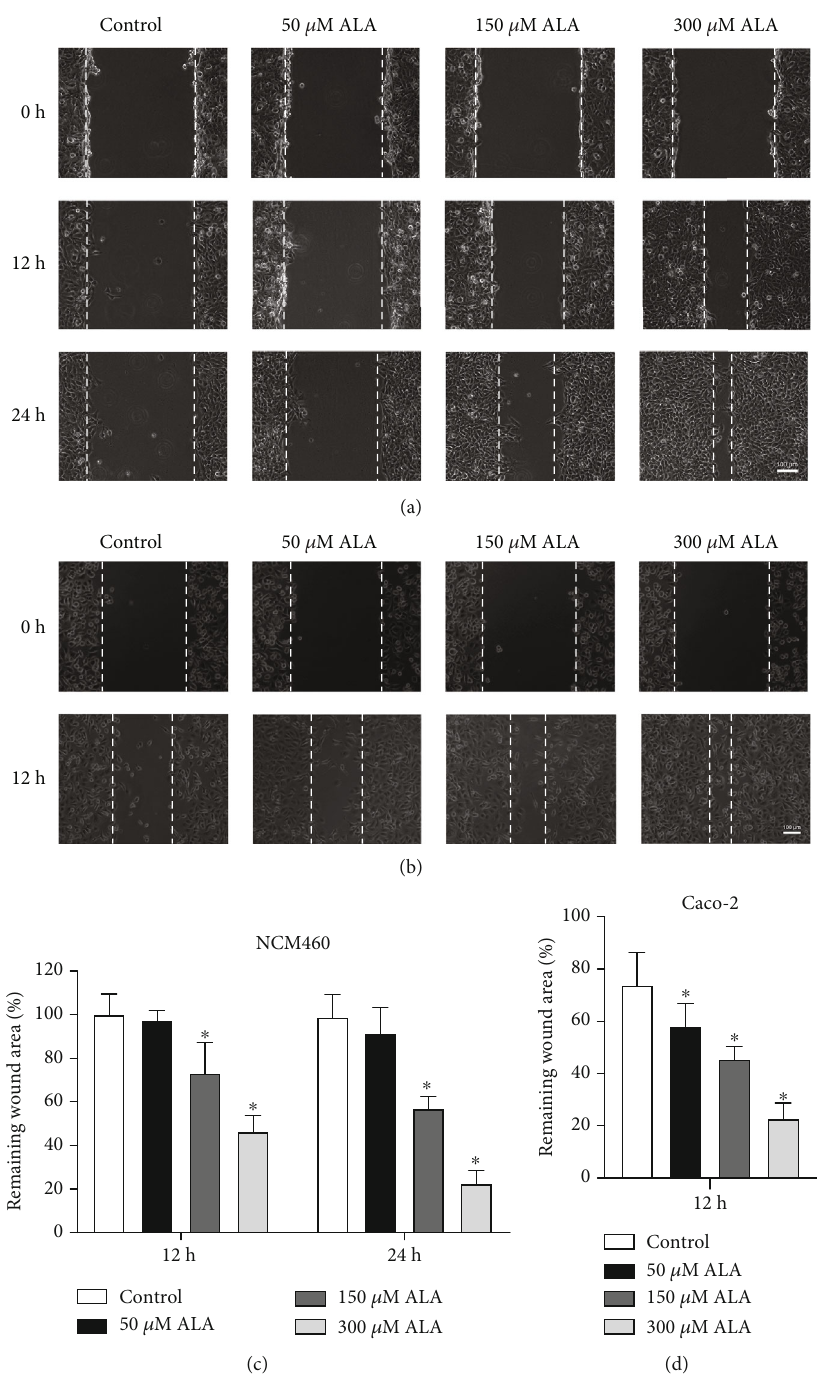
Figure 1: Restoration of epithelial cells treated with α -lipoic acid (ALA). (a) Representative images of cell wounds in wound healing assay of ALA (0 – 300 μ M) treated NCM460 cells. Wounds were created on the cell surface with the pipette tips, and then NCM460 cells were treated with ALA (0 – 300 μ M). The remaining wound areas were determined at 12h and 24 h after wound generation. (b) Representative images of cell wounds in wound healing assay of ALA (0 – 300 μ M) treated Caco-2 cells. Wounds were created, and then Caco-2 cells were treated with ALA (0 – 300 μ M). The remaining wound areas were determined at 12 h after wound generation. (c, d) The remaining wound areas in NCM460 and Caco-2 cells treated with ALA (0-300 μ M). Data are presented as mean ± SD values of three duplicates. ∗ P < 0 : 05